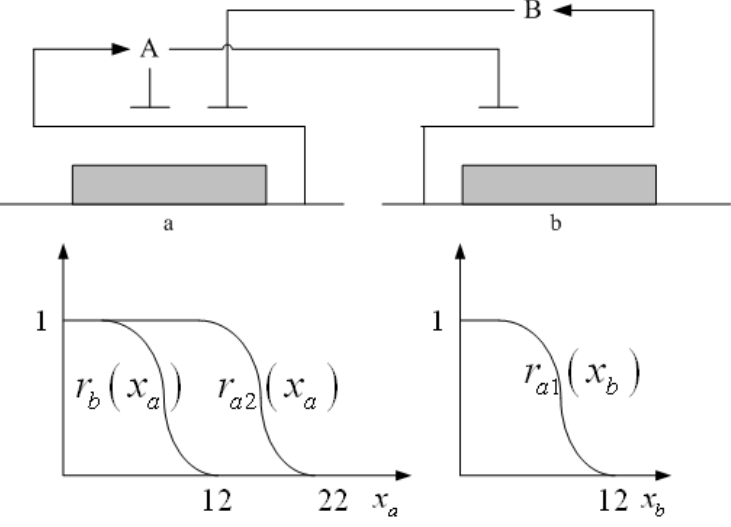
Figure 8. A simple two-gene cross-inhibition network. The network’s regulation functions are given in Equations (3.1) and